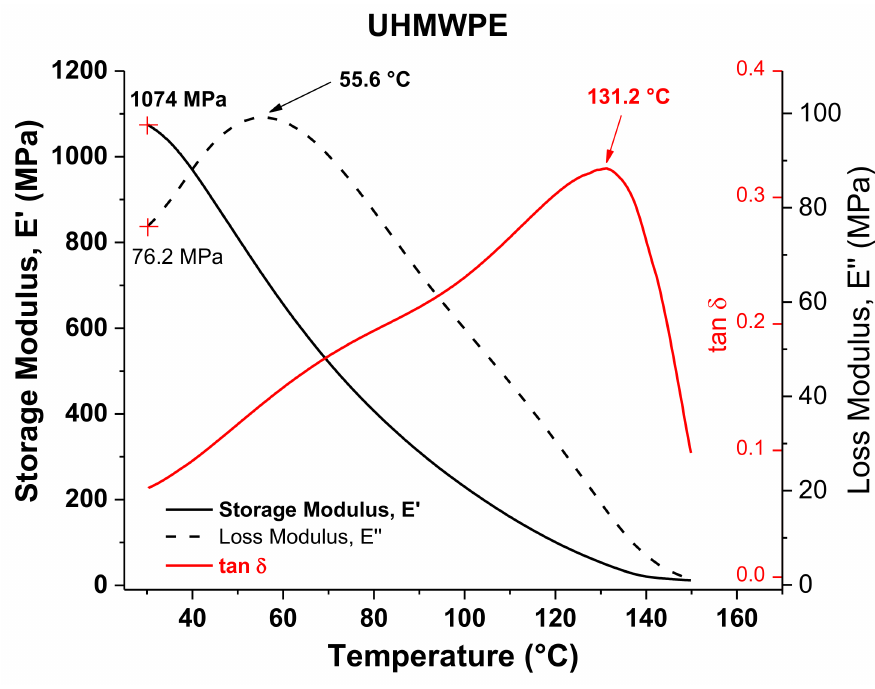
Figure 6. DMA graphs of